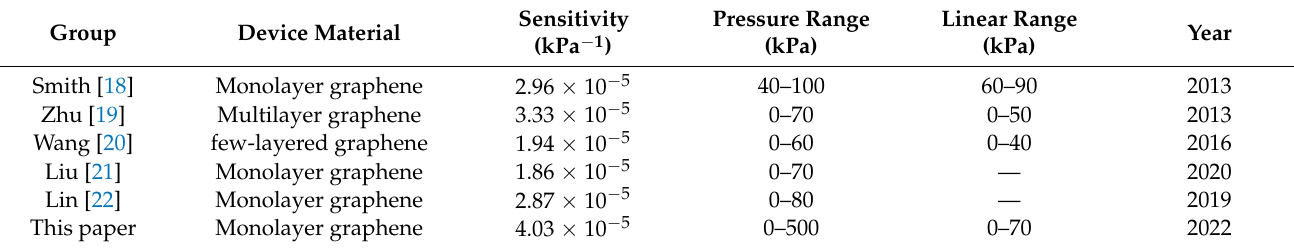
Table 1. Performance comparison among the MEMS pressure